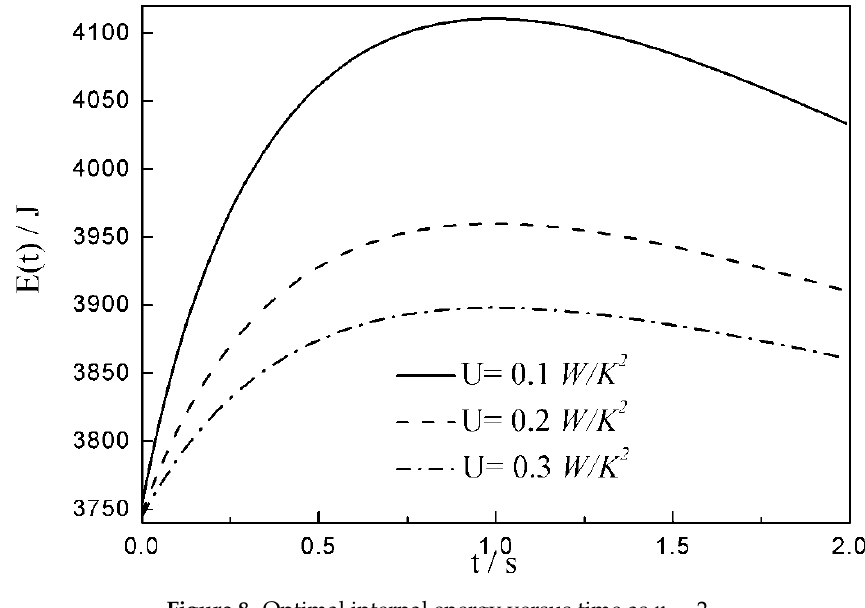
Figure 8. Optimal internal energy versus time as n = 2.